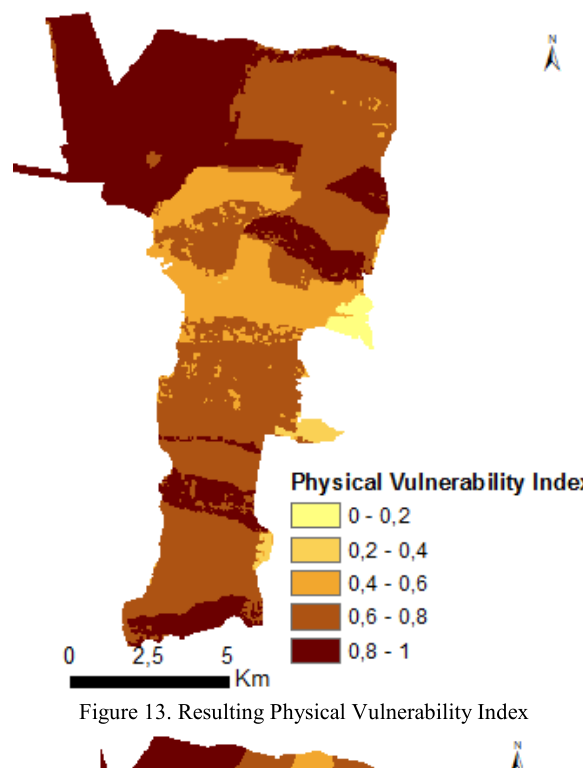
Figure 13. Resulting Physical Vulnerability Index